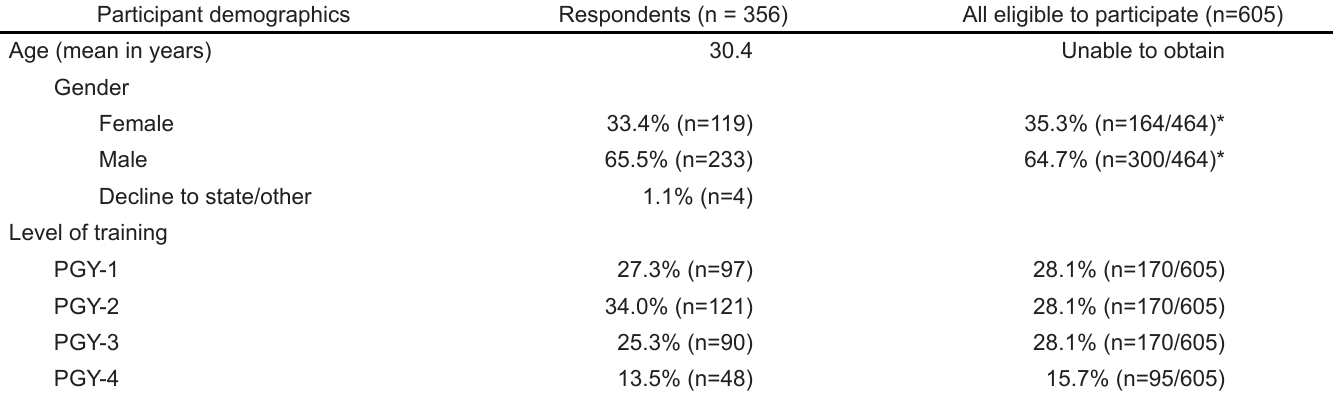
Table 1. Demographic data of survey respondents, eligible participants, programs involved in the study of educational podcast use, and all allopathic EM programs.